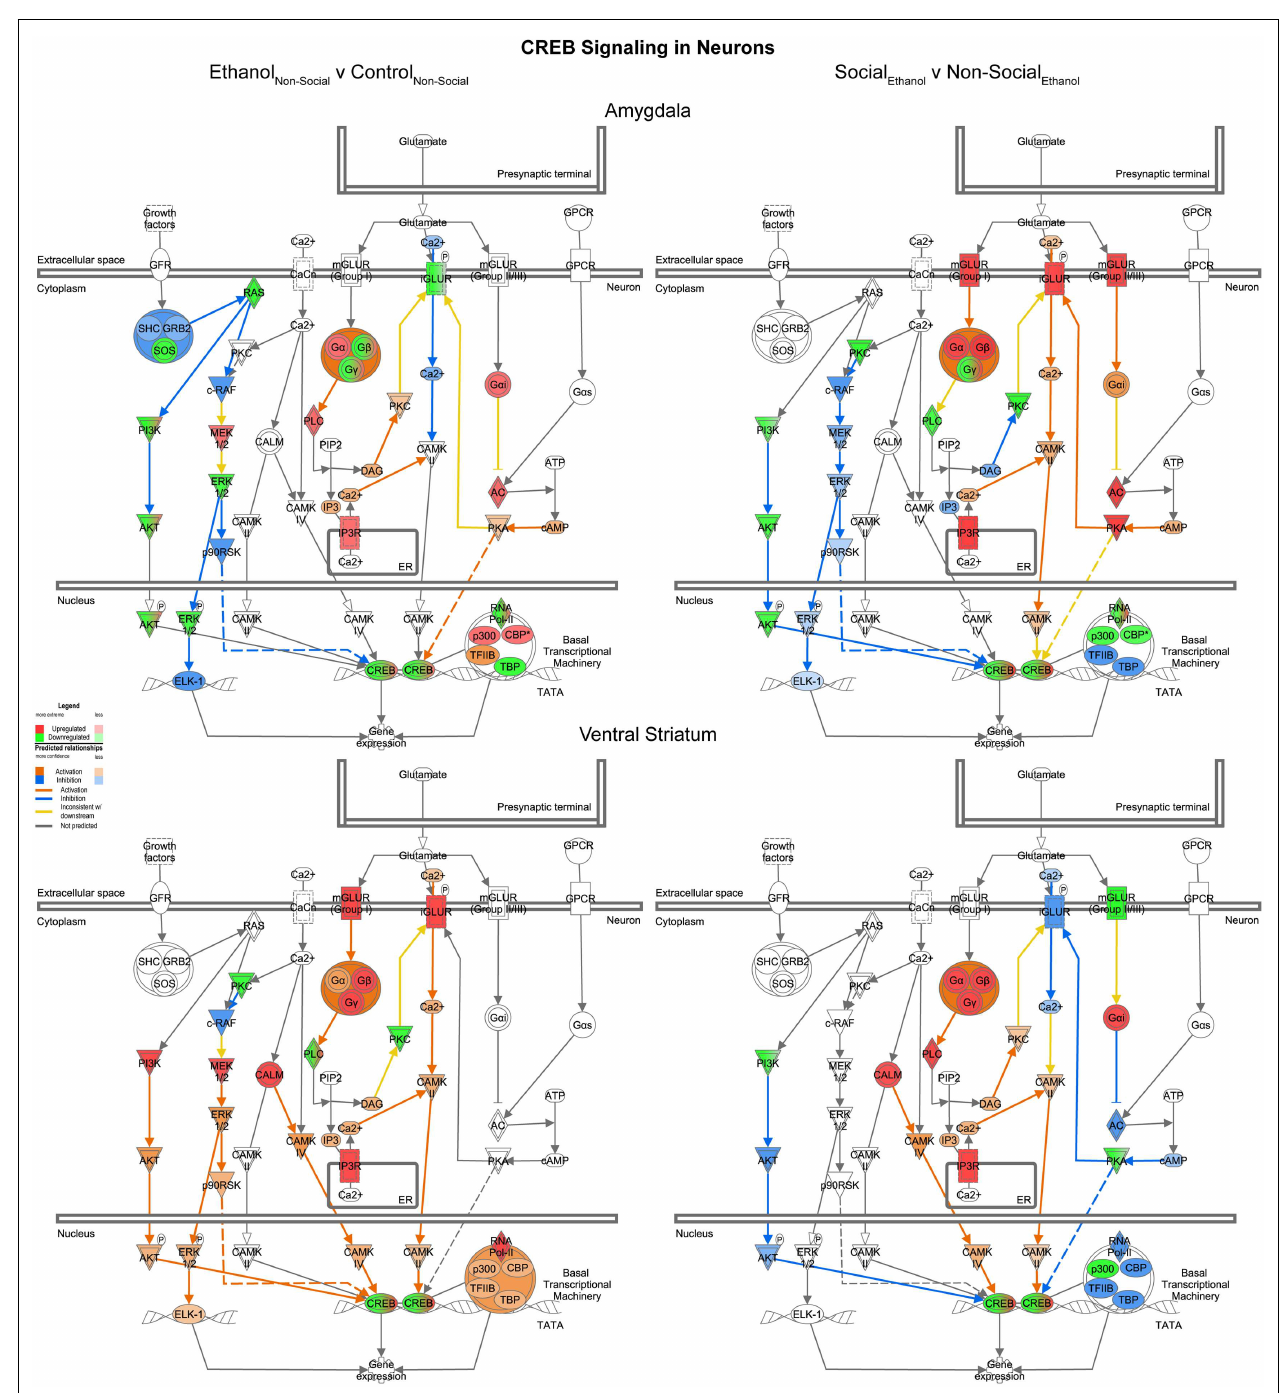
FIGURE 9 | Ethanol and social enrichment effects on CREB signaling in neurons . Conventions same as Figure 3 . Note that the changes produced following prenatal ethanol exposure or social enrichment showed somewhat complex patterns, with some evidence of both region-specific and treatment-specific